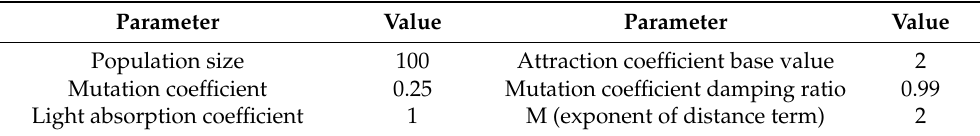
Table 6. Properties of FOA parameters.